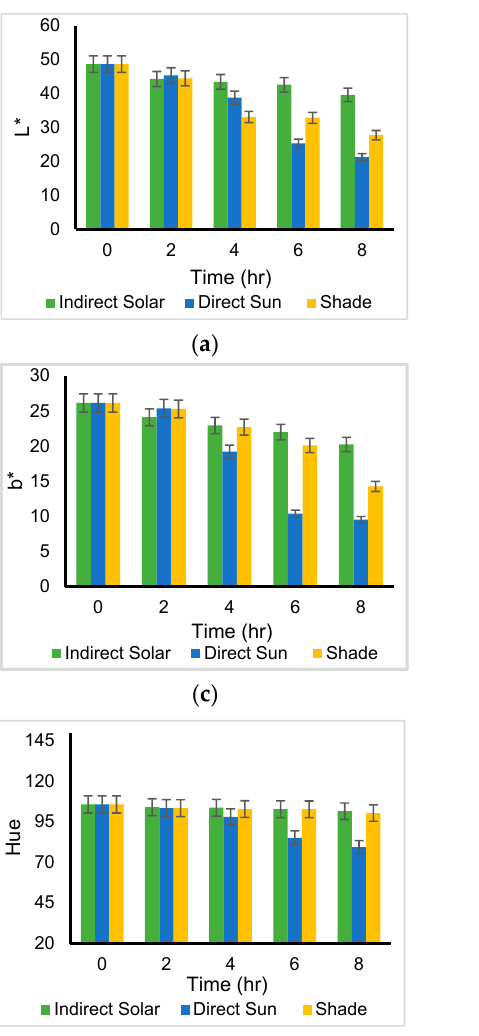
Figure 6. Basil color retention during drying process using indirect solar dryer . ( a ) Fresh, MC= 87.7%. ( b ) 2 h, MC= 47%. ( c ) 4 h, MC= 31.8%. ( d ) 6 h, MC = 21.4%. ( e ) 8 h, MC = 12.6%.